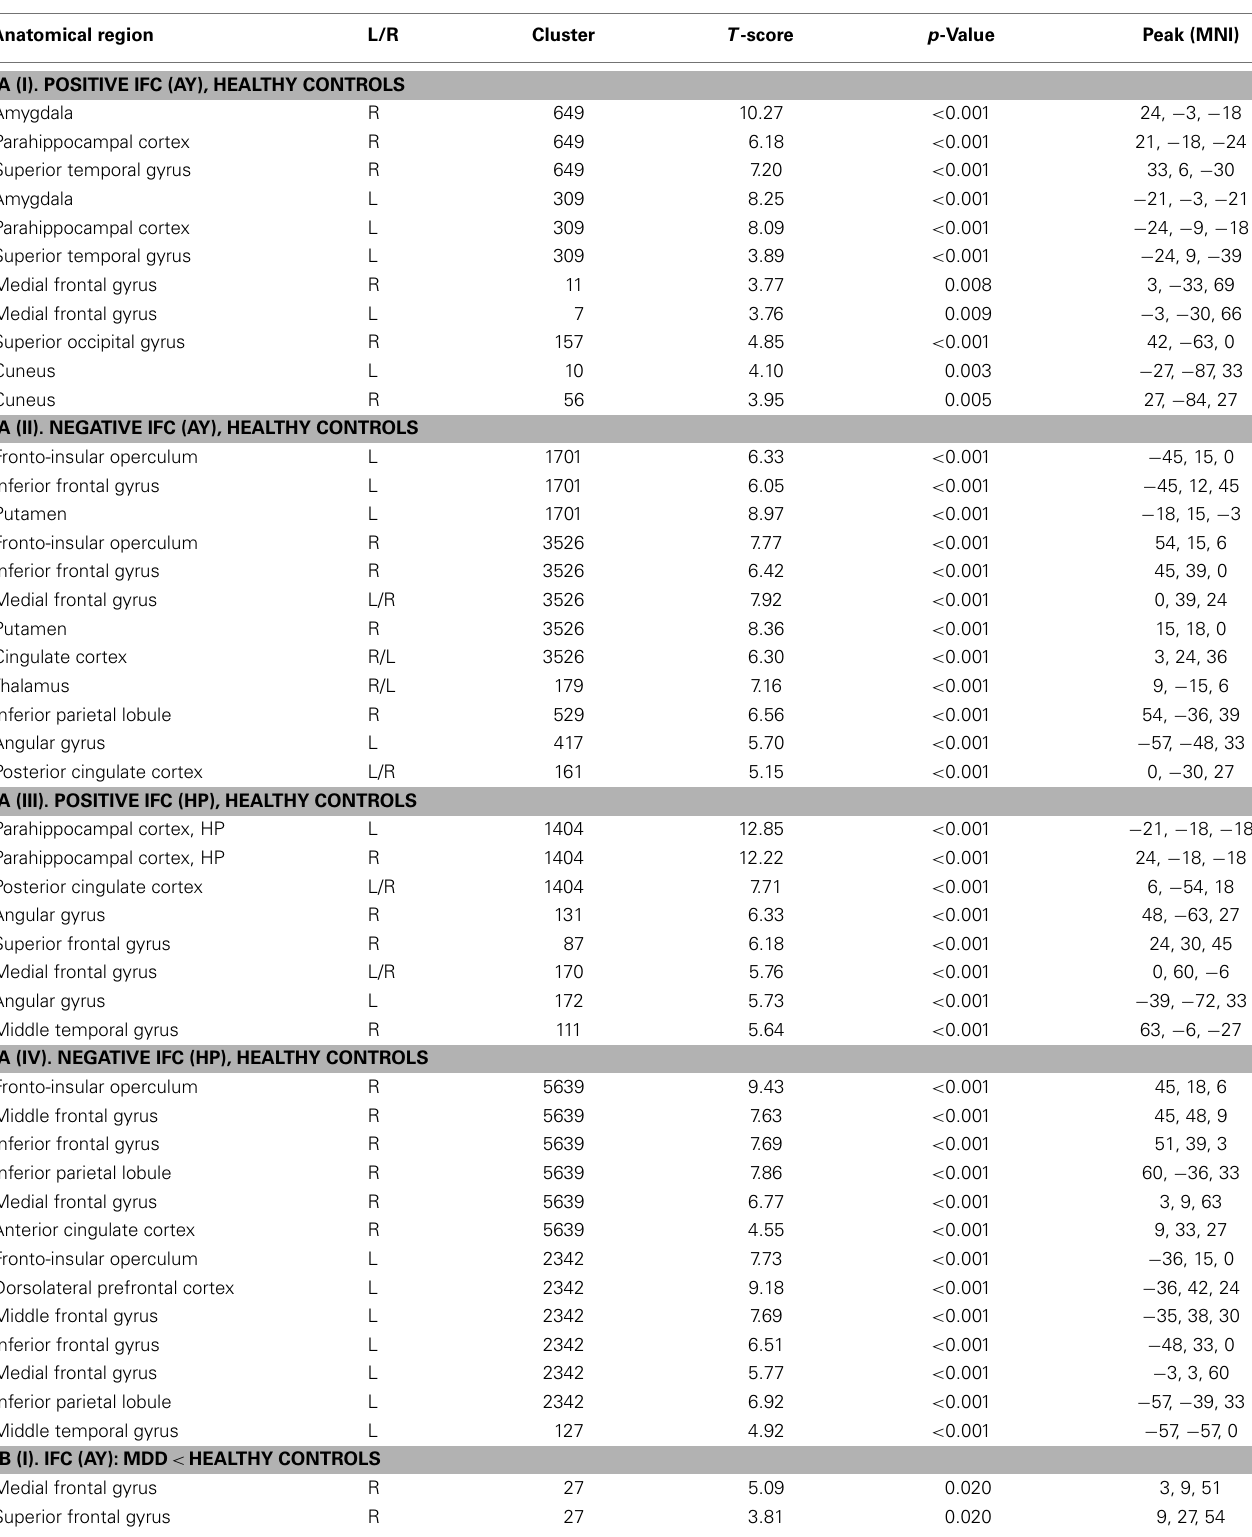
Table 2 | Regions of intrinsic functional connectivity (iFC) with amygdala (AY) and hippocampus (HP). Anatomical region L/R